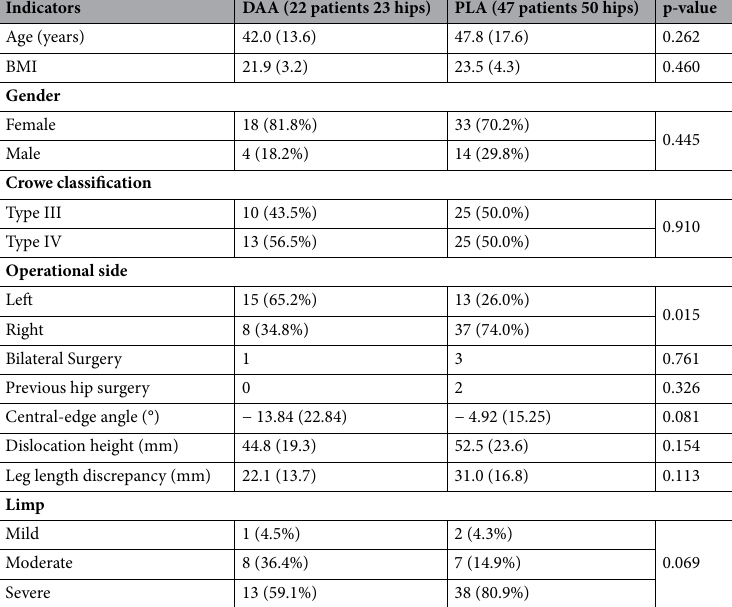
Table 1. Baseline characteristics in demographic and preoperative assessments of the two study cohorts.